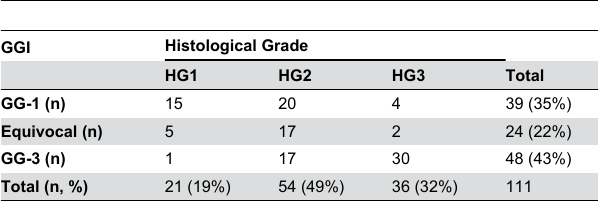
Table 1. Patient and tumor characteristics (n = 155). Table 2. Genomic Grade Index classification performance.